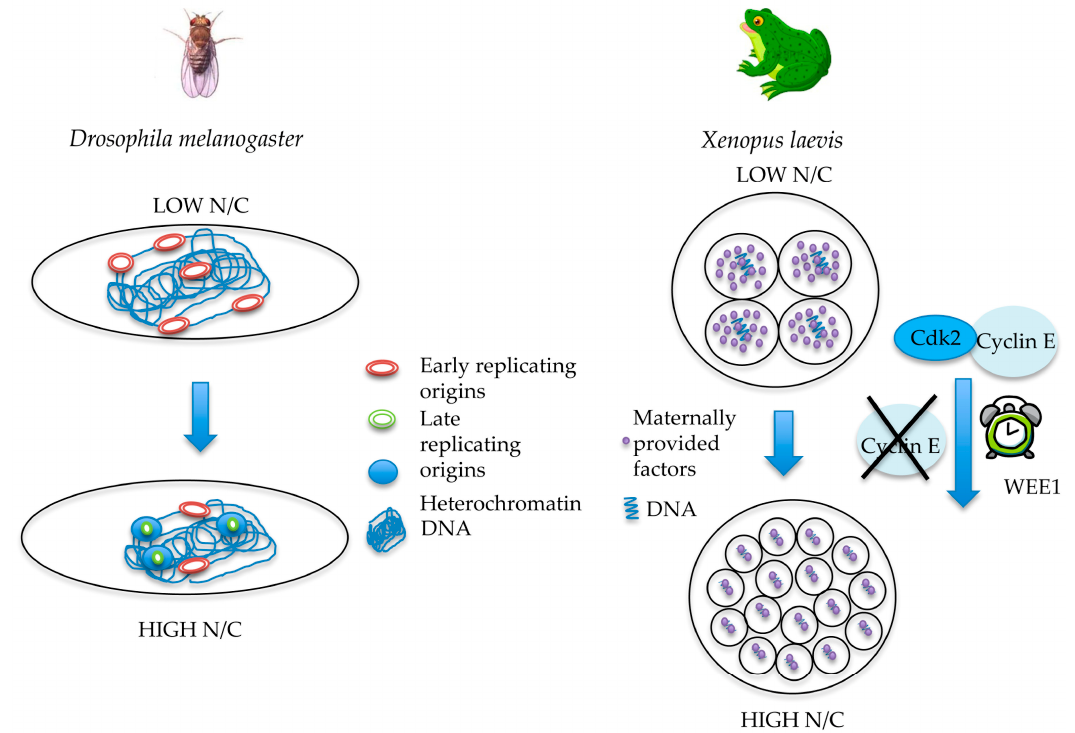
Figure 3. Schematic representation of mechanisms leading to S-phase lengthening at the MBT in Drosophila and Xenopus . In Drosophila, the establishment of heterochromatin, concomitant to the increase in the N/C ratio, contributes to S-phase lengthening after MBT. In Xenopus, titration of maternally inherited factors by the increased N/C ratio and degradation of Cyclin E participate in increasing S-phase length at the MBT. The WEE1 gene is implicated in regulating the timer for MBT onset by acting on the stability of the Cyclin E/CDK2 complex.